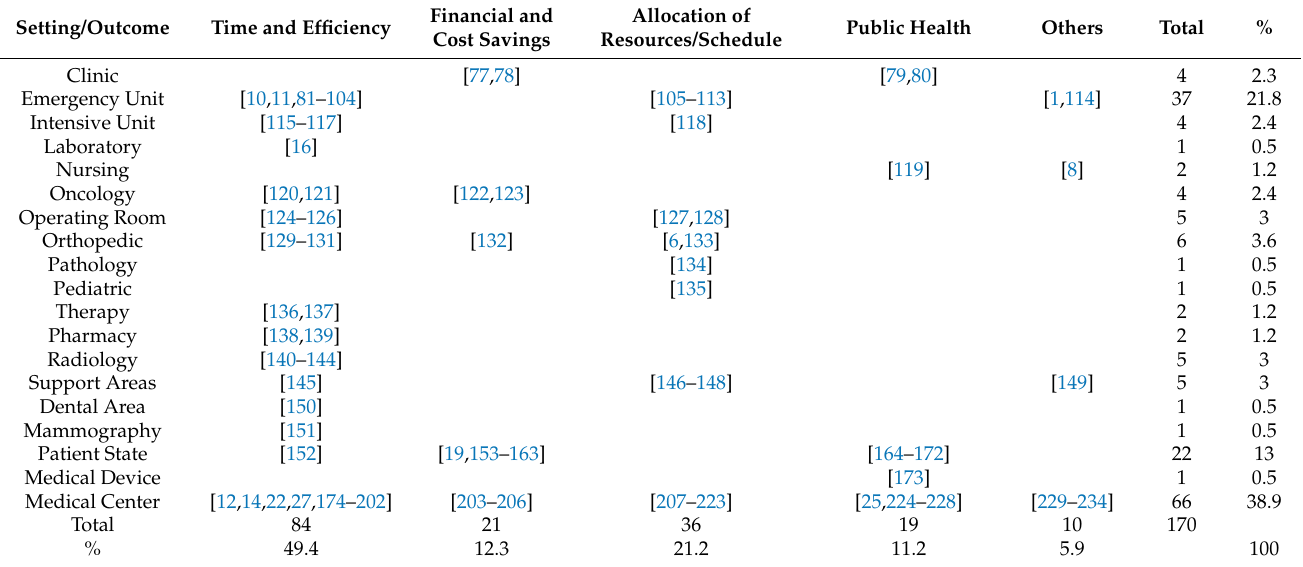
Table 4. Discrete-event simulation publications classified by setting and